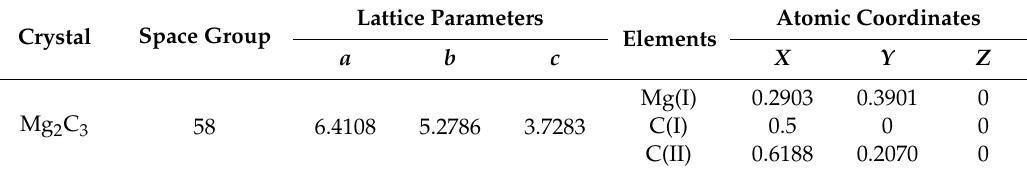
Table 2. Lattice parameters of Mg 2 C 3 .